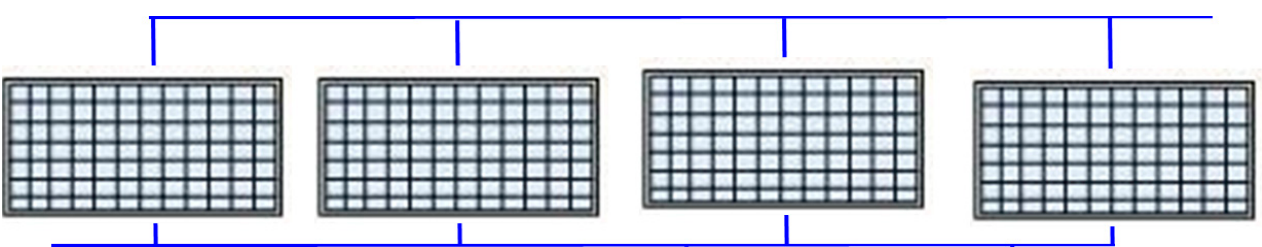
Figure 5. Solar voltaic panels in a parallel configuration [9].